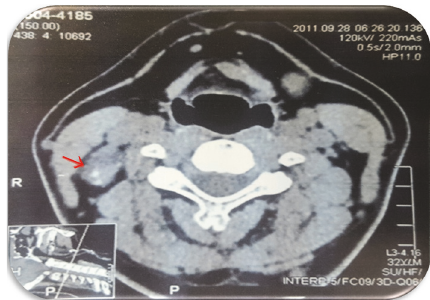
Figure 3: Whole-body scan. Functional thyroid tissue remnants in thethyroidbedwithmultipleenlargednecklymphnodes.Redarrow indicates functional thyroid tissue remnants in the thyroid